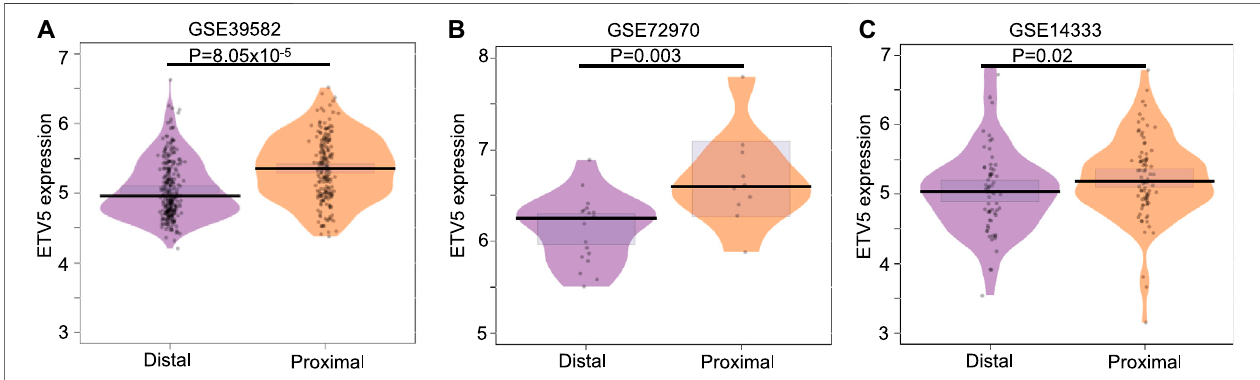
FIGURE2| ComparisonofETV5 (A – C) expression indistalandproximaltumorsofcombined stageIIandIIIcoloncancerpatientsfromCIT(GSE39582leftpanel), metastatic (GSE72970 middle panel) and GSE14333 (right panel) cohorts. The p -value has been calculated using the Wilcoxon test.